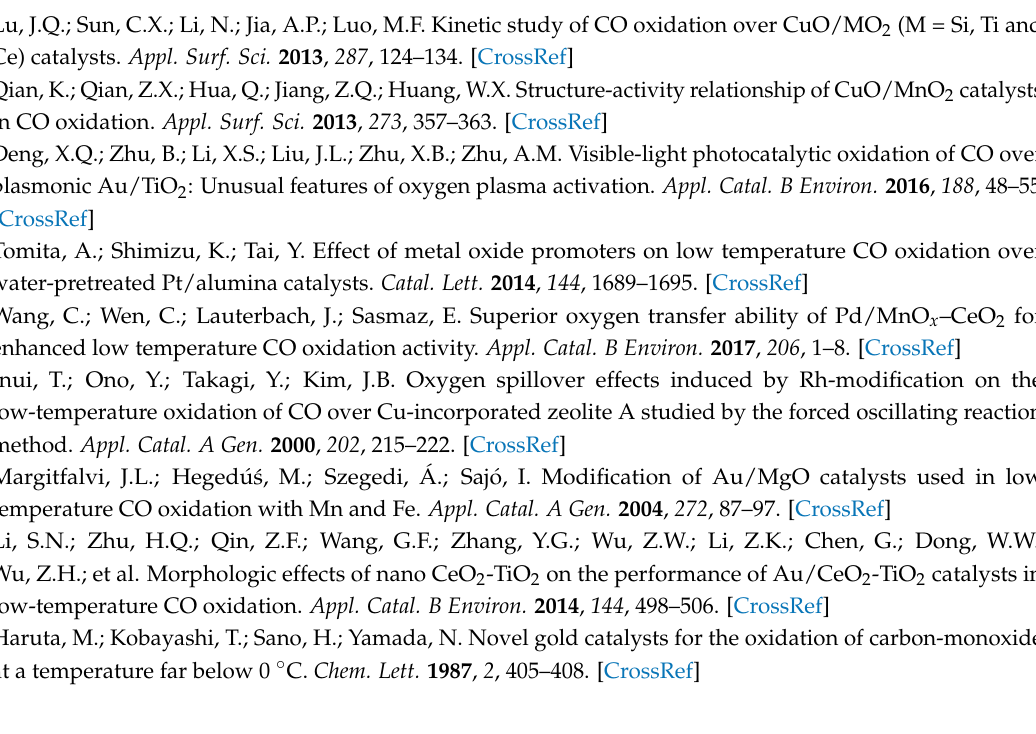
Figure S1: XRD patterns of Bi 2 WO 6 and Bi 2 WO 6 -400 supports, Figure S2: XRD patterns of Au/Bi 2 WO 6 (a) and Au/Bi 2 WO 6 -400 (b) with different Au-content, Figure S3: XRD patterns of Au/Bi 2 WO 6 -400 was calcined at different temperatures, Figure S4: XRD patterns of CuO/Bi 2 WO 6 (a) and CuO/Bi 2 WO 6 -400 (b) with different Cu-content, Figure S5: XRD patterns of Bi 2 WO 6 (a), Au–CuO/Bi 2 WO 6 (b) Cu 1.64 wt %, Au 0.415 wt %; (c) Cu 3.27 wt %, Au 0.425 wt %; (d) Cu 4.85 wt %, Au 0.438 wt %; (e) Cu 6.61 wt %, Au 0.448 wt %, Figure S6: EDX of the Au/Bi 2 WO 6 -400: Au 1.30 wt % (a) CuO/Bi 2 WO 6 –C: Cu 5.10 wt % (b) and Au–CuO/Bi 2 WO 6 –C: Cu 4.85 wt %, Au 0.438 wt % (c), Figure S7: XPS spectra of Au/Bi 2 WO 6 -400: Au 1.30 wt % (300 ◦ C): Bi 4f peaks (a); W 4f peaks (b); O 1s peaks (c); Au 4f peaks (d), Figure S8: XPS spectra of CuO/Bi 2 WO 6 -400: Cu 5.10 wt %: Bi 4f peaks (a); W 4f peaks (b); O 1s peaks (c); Cu 2p peaks (d), Figure S9: TEM image of Au/Bi 2 WO 6 -400 (calcinated at 400 ◦ C): Au 1.30 wt %, Table S1: The flower-like Au/Bi 2 WO 6 microspheres catalysts, Table S2: The flower-like CuO/Bi 2 WO 6 microspheres catalysts; Table S3 The flower-like Au-CuO/Bi 2 WO 6 microspheres